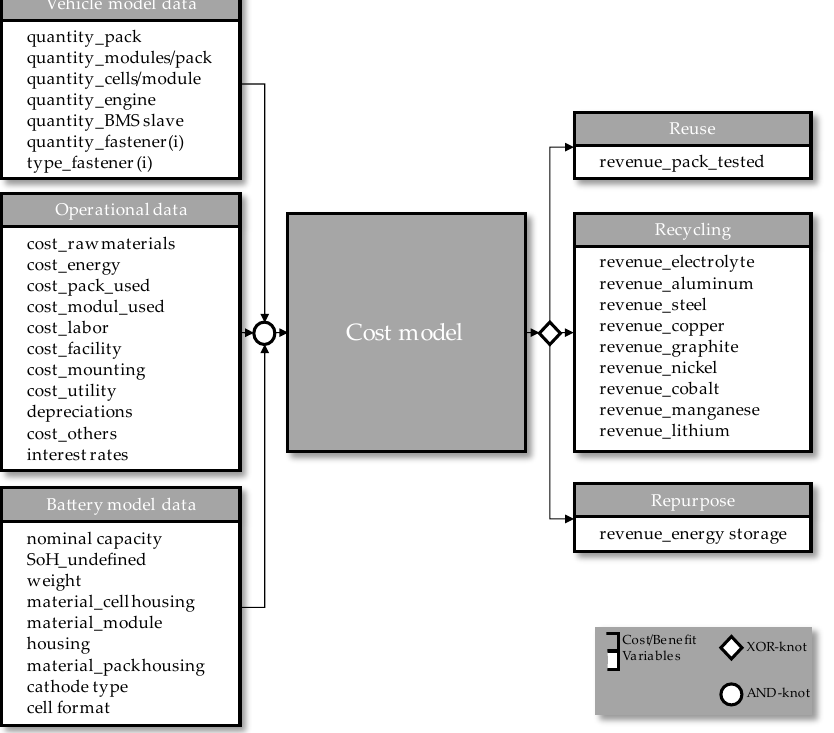
Figure 5. Cost model for CBA with in- and output variables.